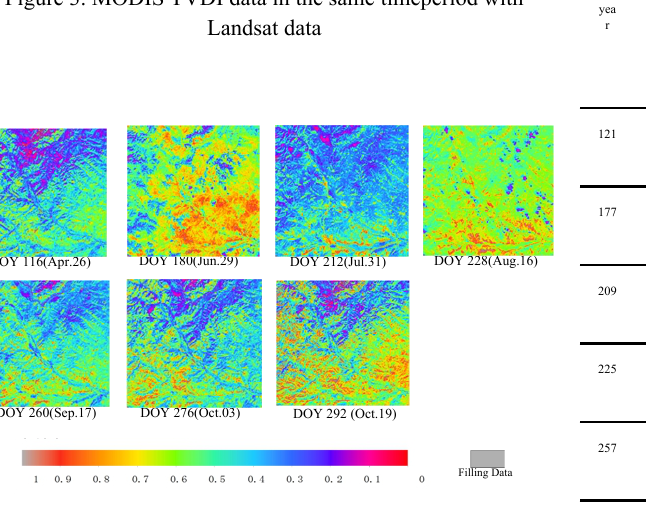
Figure 3. MODIS TVDI data in the same timeperiod with